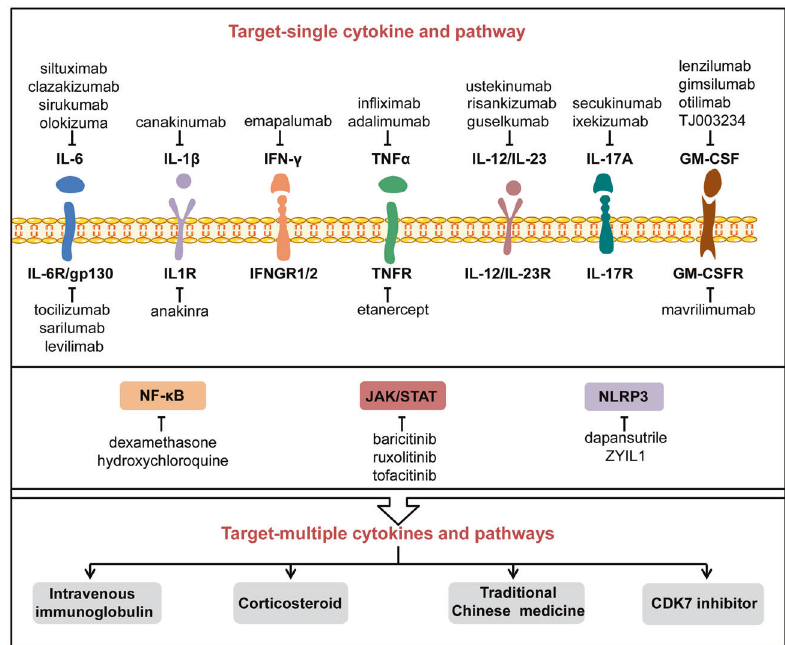
Fig. 6 The potential inhibitors and therapies to counteract COVID-CS. A variety of inhibitors or drugs have been applied or are under consideration to treat COVID-CS, including those targeting a single pro-in fl ammatory cytokine or its receptor and related signal pathway. In addition, several treatments such as intravenous immunoglobulin, corticosteroids, traditional Chinese medicine, and CDK7 inhibitor may have the potential to counteract multiple cytokines and pathways involved in COVID-CS. CDK7 cyclin-dependent kinase